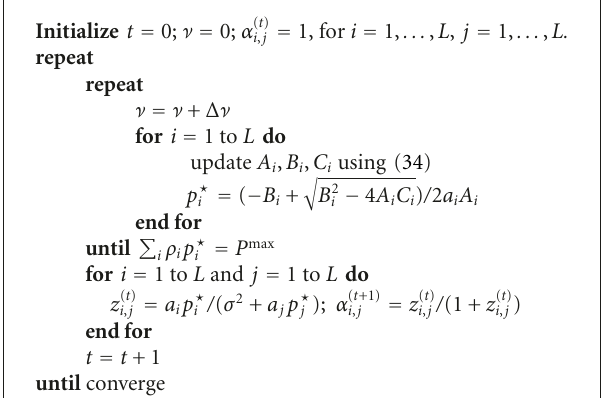
Algorithm 1: Lower Bound Tightening